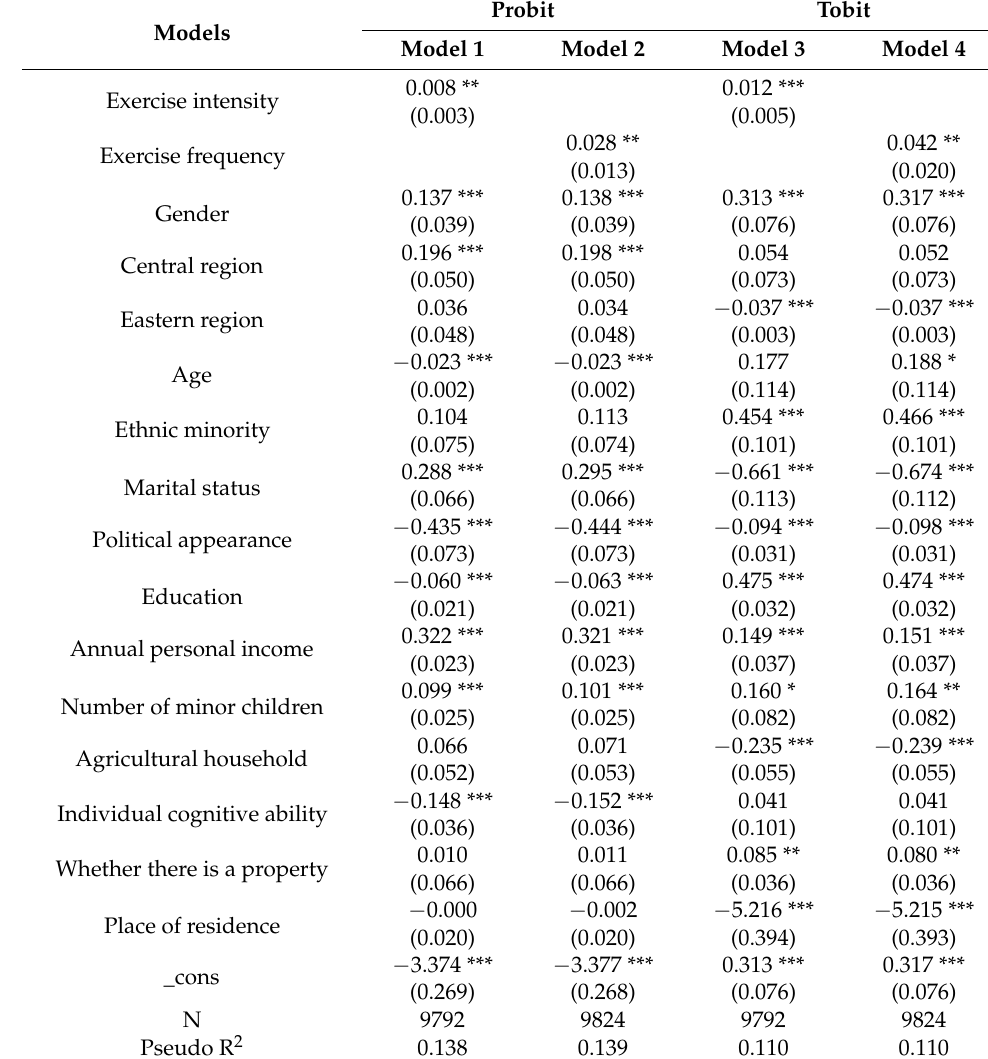
Table 2. Effect of physical exercise on entrepreneurial